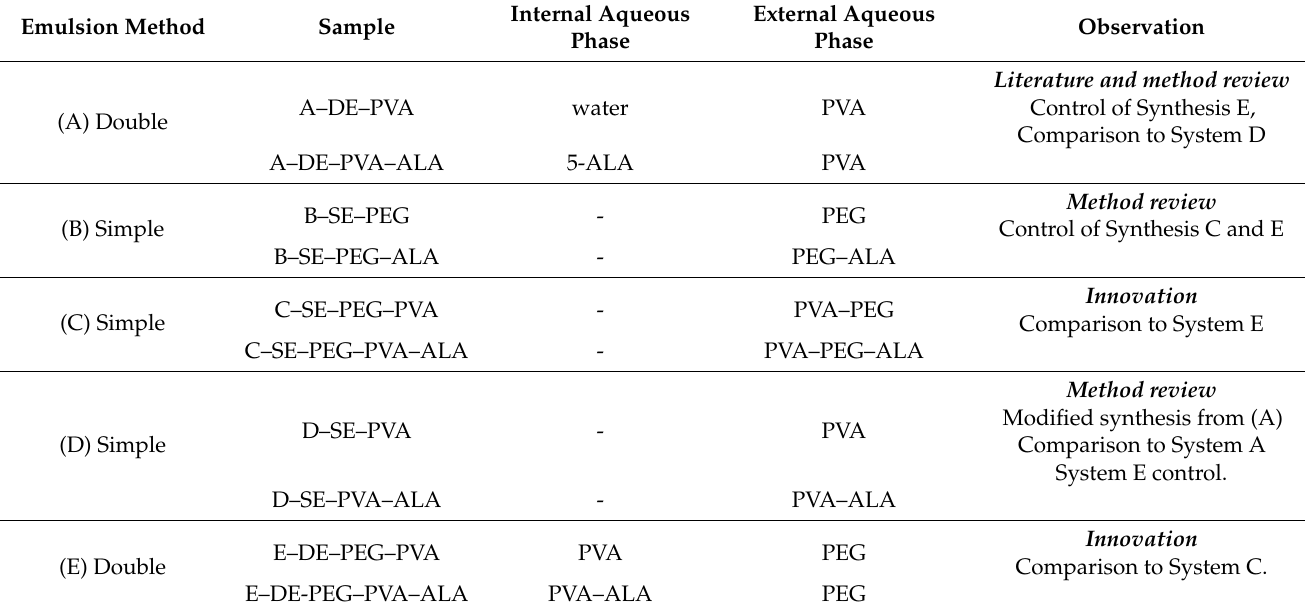
Table 2. Systems